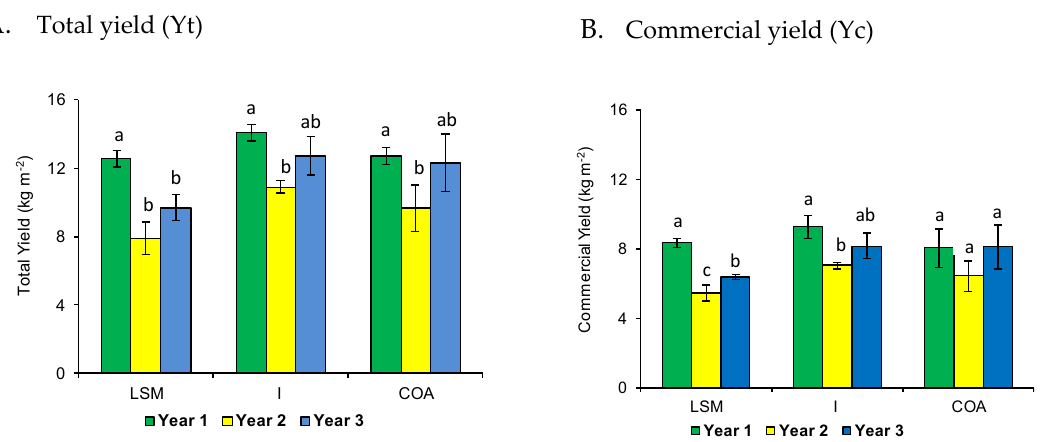
Figure 1. ( A ). Total yield (Yt) and ( B ). commercial yield (Yc) of celery, as a function of the fertilization treatment: local sheep manure (LSM), mineral (I), and commercial organic amendment (COA). “a”